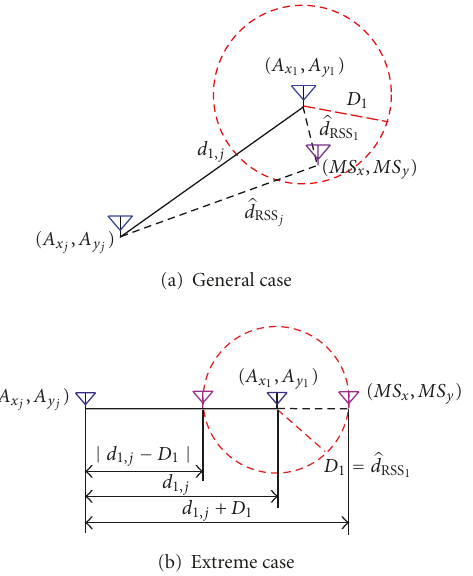
Figure 2: Graphical representation of the heuristic constraint D 1 in a time interval ( t 1 , t N ).